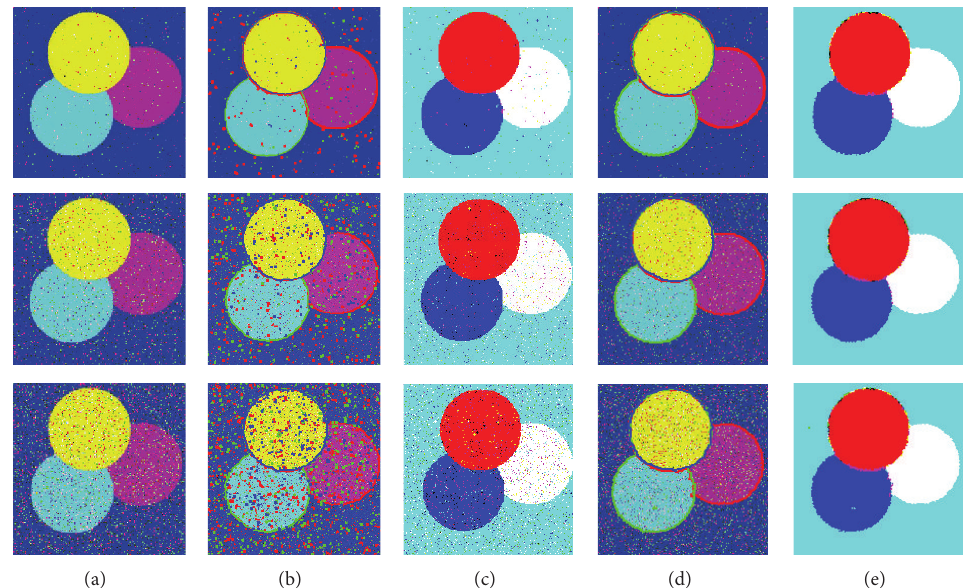
Figure 8: Results for a synthetic image added with salt and pepper noise with deviations 0.01, 0.05, and 0.1, respectively. (a) Original noisy images; (b) the final contours of the STP-CV model; (c) the segmentation results labeled with different colors of the STP-CV model; (d) the final contours of the proposed model; (e) the segmentation results labeled with different colors of the proposed model.